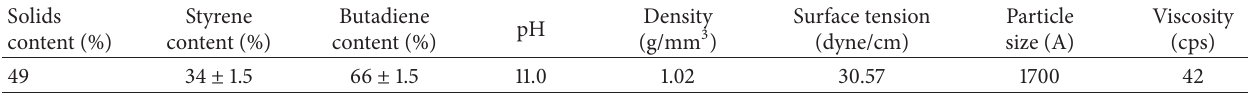
Table 1: Properties of latex polymer.